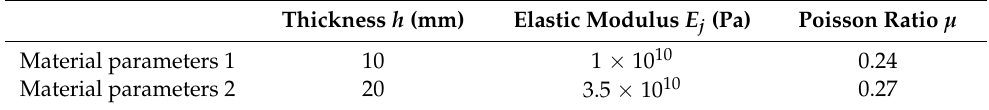
Table 6. Material parameters of sandwich.